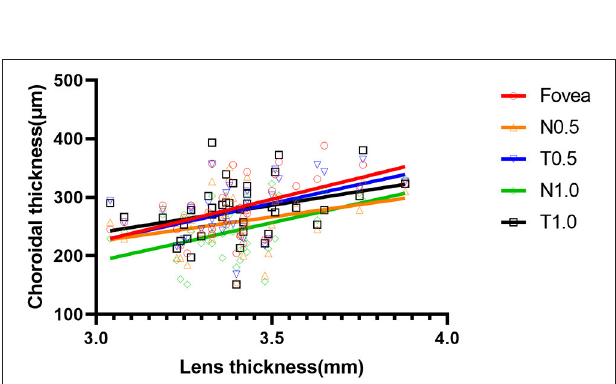
FIGURE 6 | Scatter plot of the correlation between lens thickness and choroidal thickness at five measurement points at 6 months of the orthokeratology (Ortho-K)